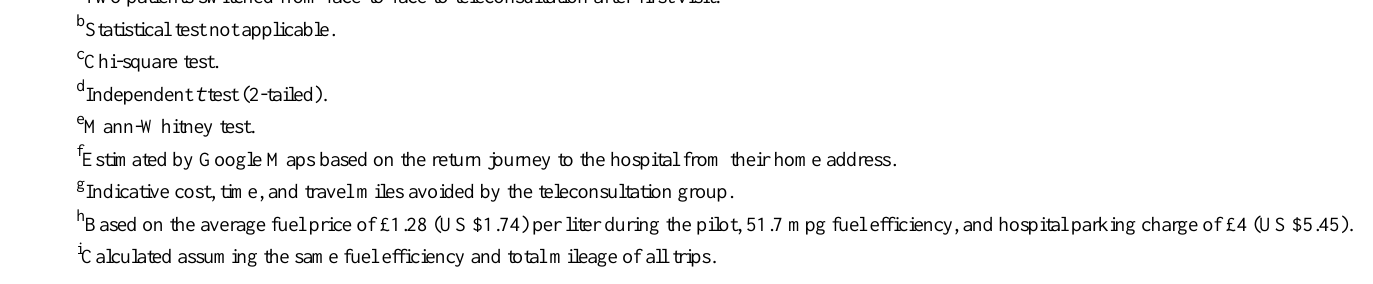
P valueTeleconsultationFace to faceCharacteristic and